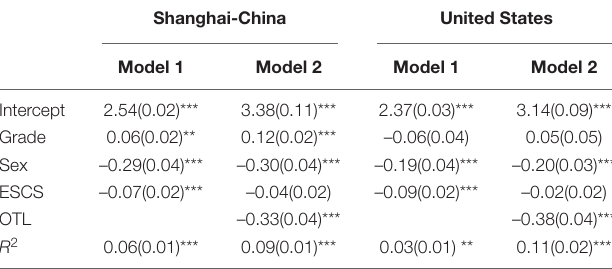
TABLE 2 | Effects of OTL on student mathematics